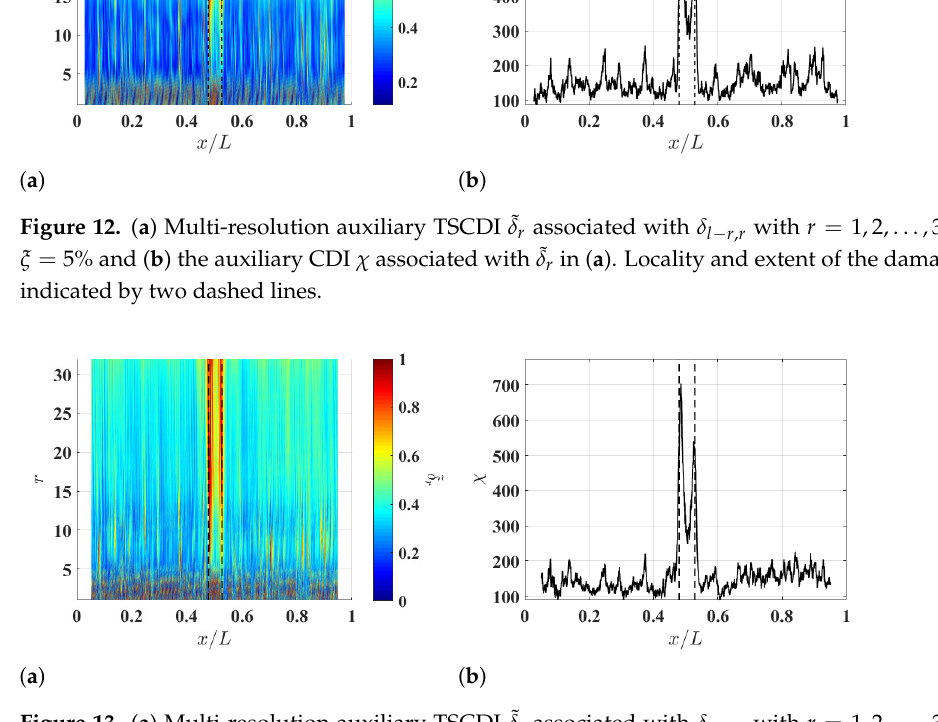
Figure 13. ( a ) Multi-resolution auxiliary TSCDI ˜ δ r associated with δ l − r , r with r = 1,2, . . . ,32 and ξ = 10% and ( b ) the auxiliary CDI χ associated with ˜ δ r in ( a ). Locality and extent of the damage are indicated by two dashed lines.